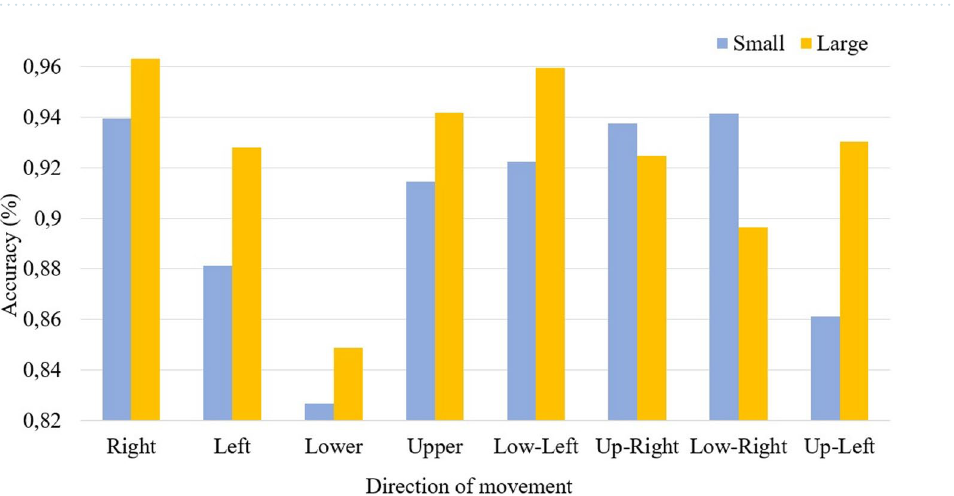
Figure 5. Reconstruction errors for all directions for the small bending of 0.1–0.5 cm ( a ) and large bending of 0.6–1 cm ( b ).